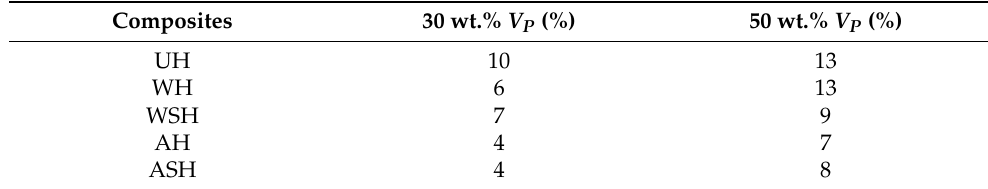
Table 3. Volume of porosities of the